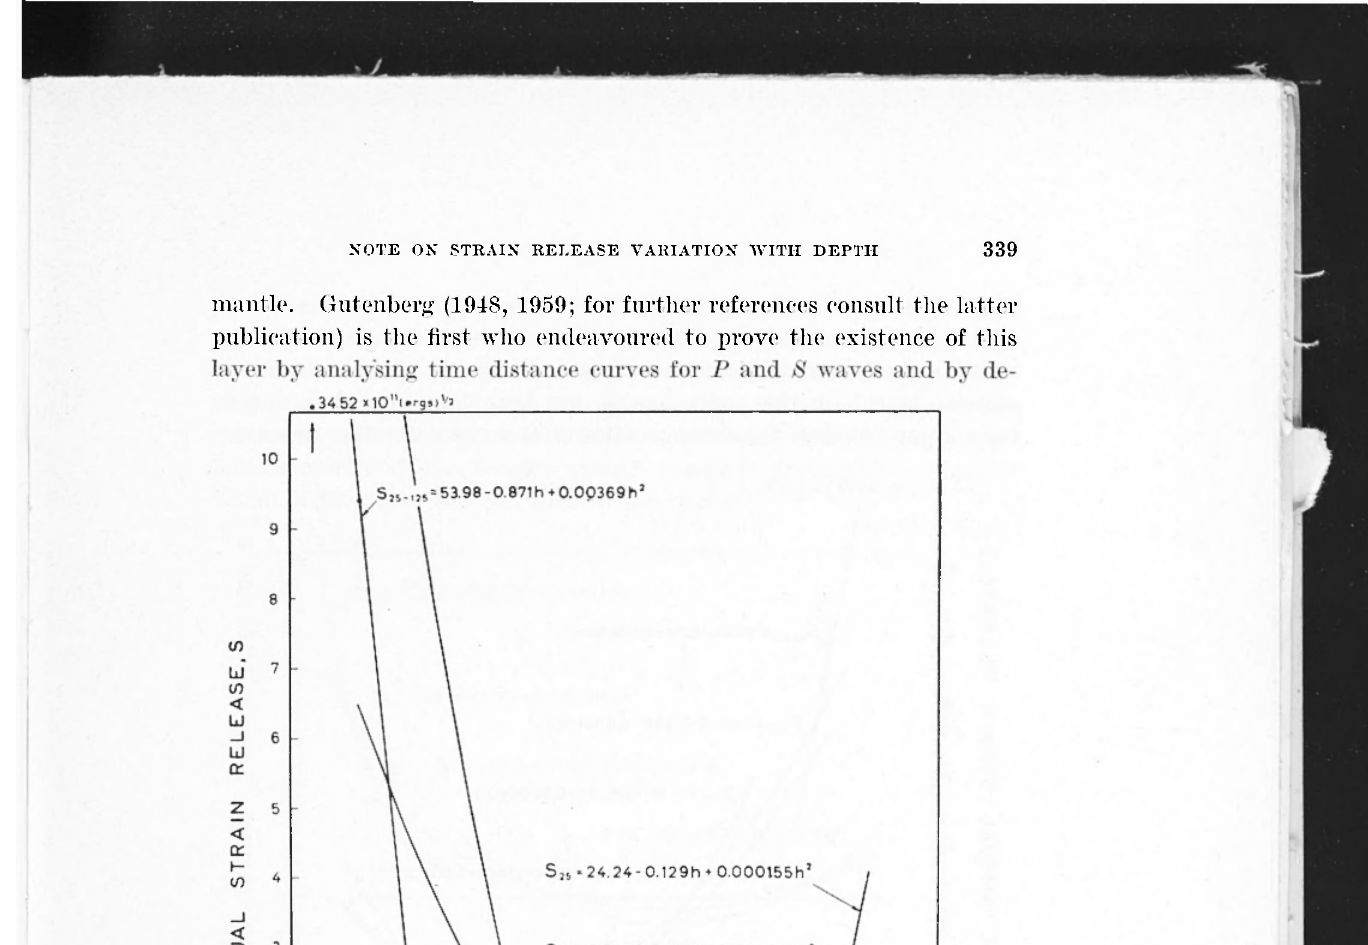
Fig. 1 - Global strain release variation with